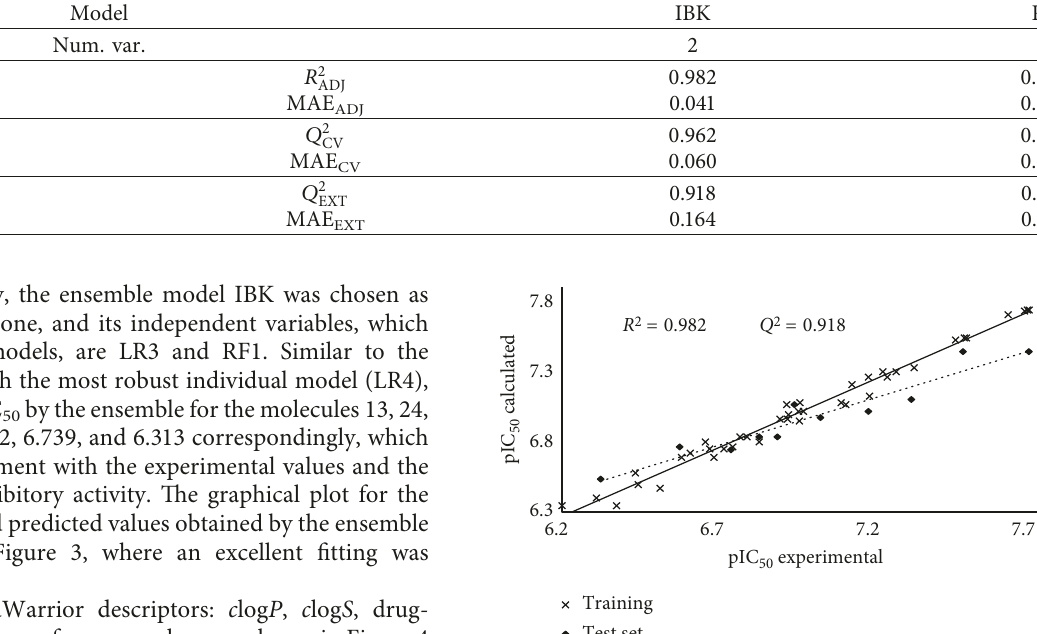
Figure 3: Graphical plot between experimental and calculated pIC 50 by IBK